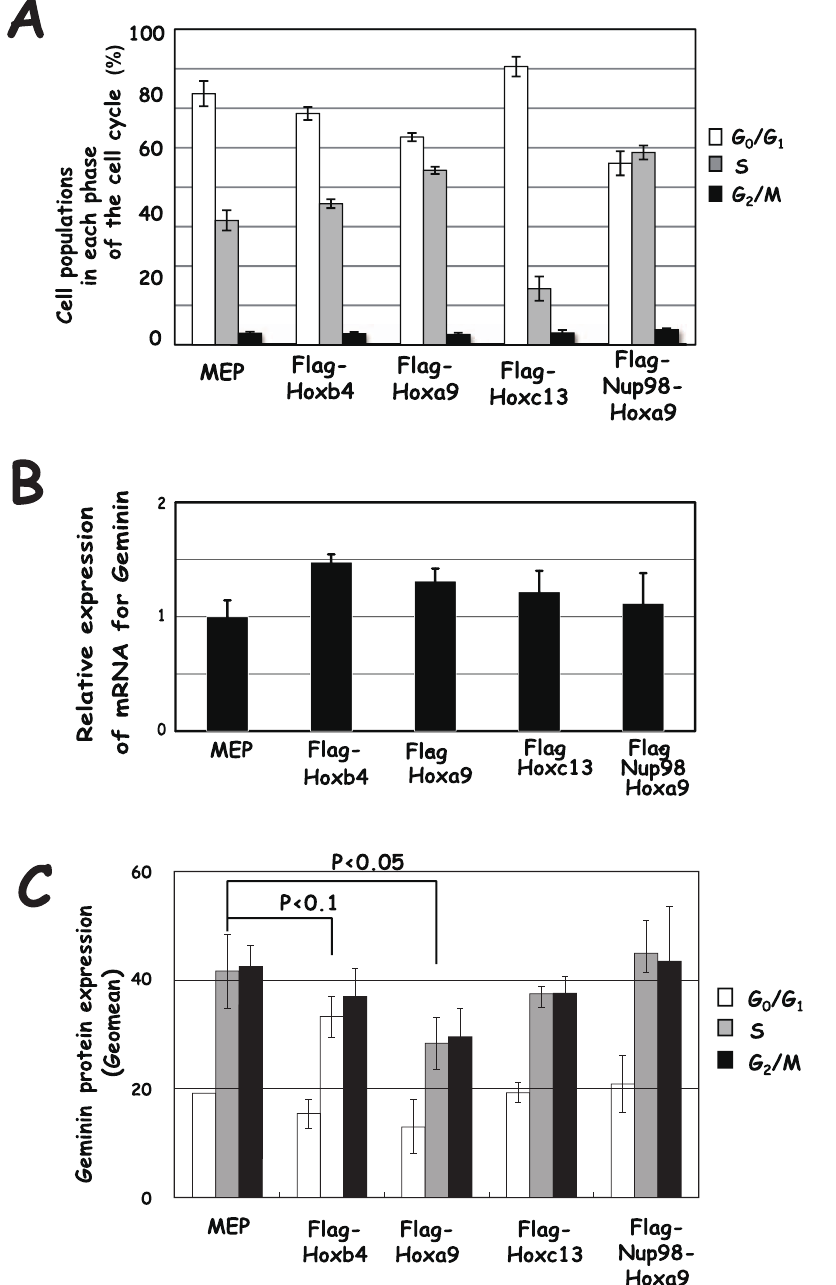
Figure 4. Effects of Hoxb4, Hoxa9, Hoxc13 and Nup98-Hoxa9 transduction on BM. Retrovirally transduced cells were subjected to flow cytometry analysis as well as to real-time PCR analysis. ( A ) Cell populations in each phase of the cell cycle were analyzed by cell sorting analysis. ( B ) Relative expression of mRNA for Geminin. ( C ) Geminin protein expression in each phase of the cell cycle. Geomean of the fluorescence intensity was shown. MEP, an empty control